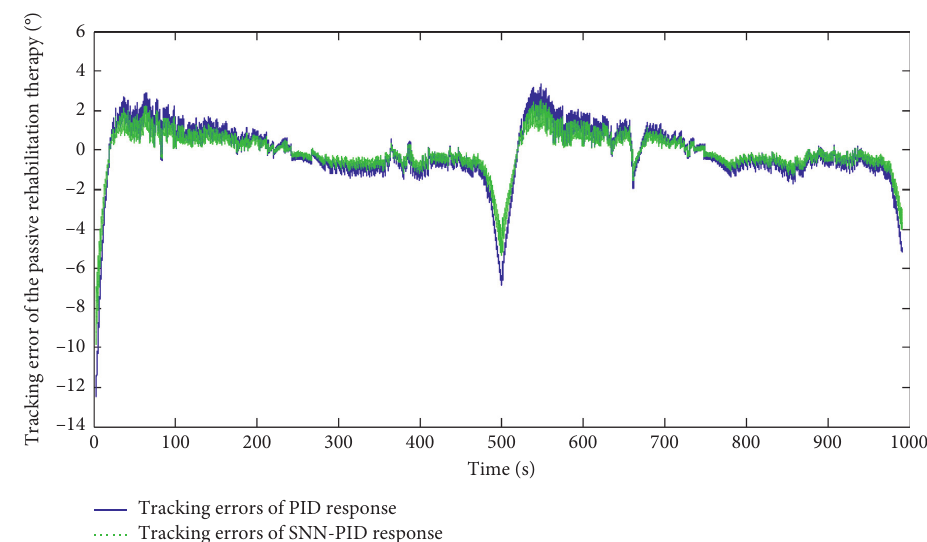
Figure 8: Tracking errors of passive rehabilitation therapy experiment under a half sinusoidal wave excitation of 0.002Hz with amplitude 50 °